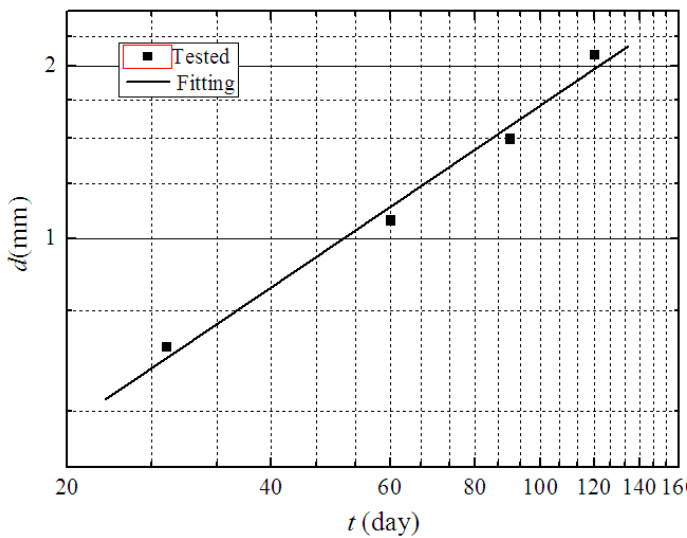
Figure 8. Fitting curve of deterioration depth of soil-cement with age.